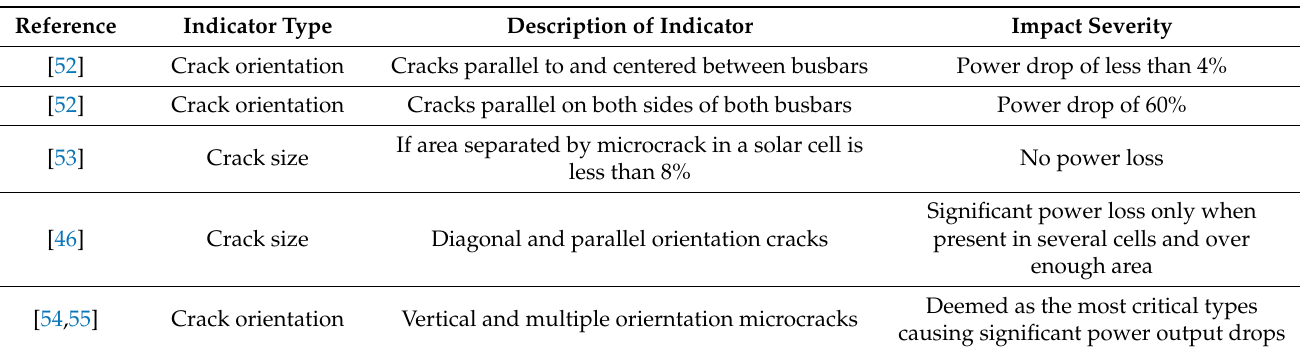
Table 4. Summary of the key findings from the literature outlining how the severity of microcracks with respect to power output can be